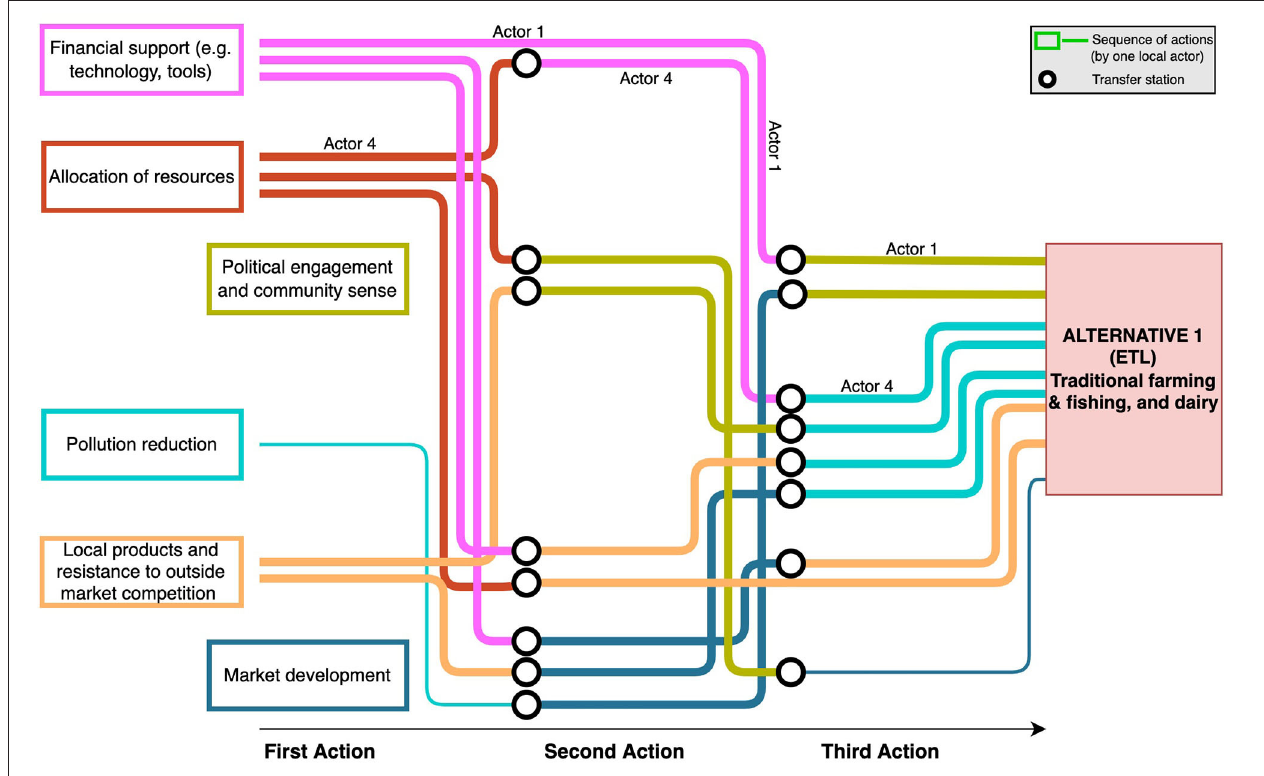
FIGURE 4 | Pathways towards the extended traditional livelihood